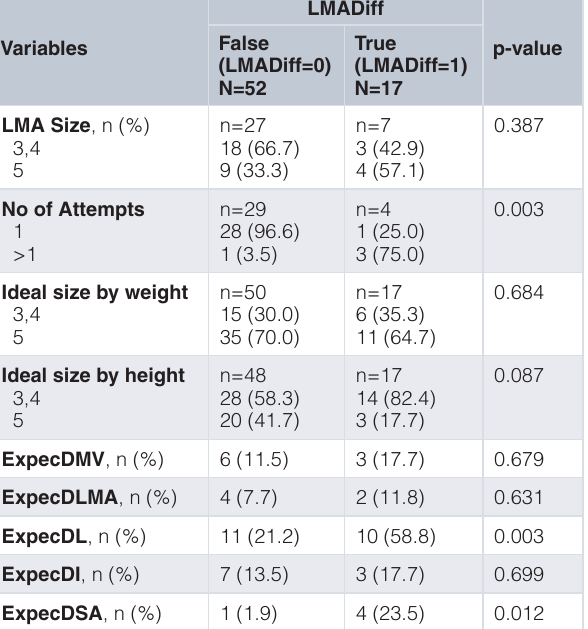
Table 3. LMA size and expected outcome by LMADiff status.